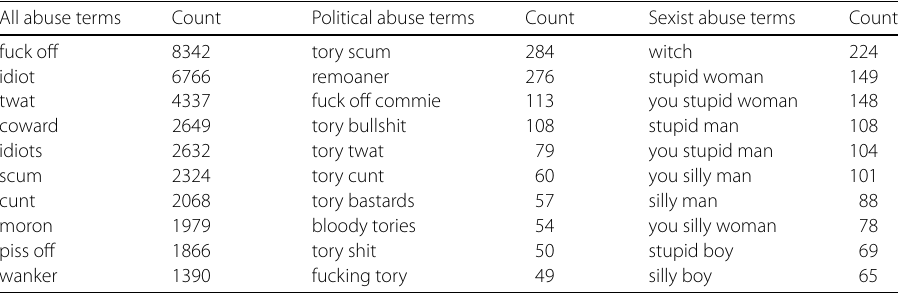
Table 5 Most frequently found abusive terms for all abuse types and for political and sexist abuse, alongside count for the whole corpus All abuse